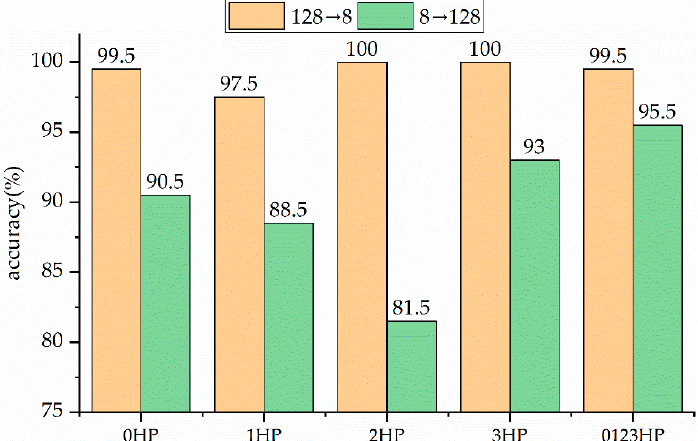
Figure 3. The influence of the number and size of convolution kernel on the accuracy of the model Where “128 → 8” means the number of convolution kernels is 128, 64, 32, 16, and 8 in sequence; “8 → 128” means that the number of convolution kernels is 8, 16, 32, 64, and 128 in